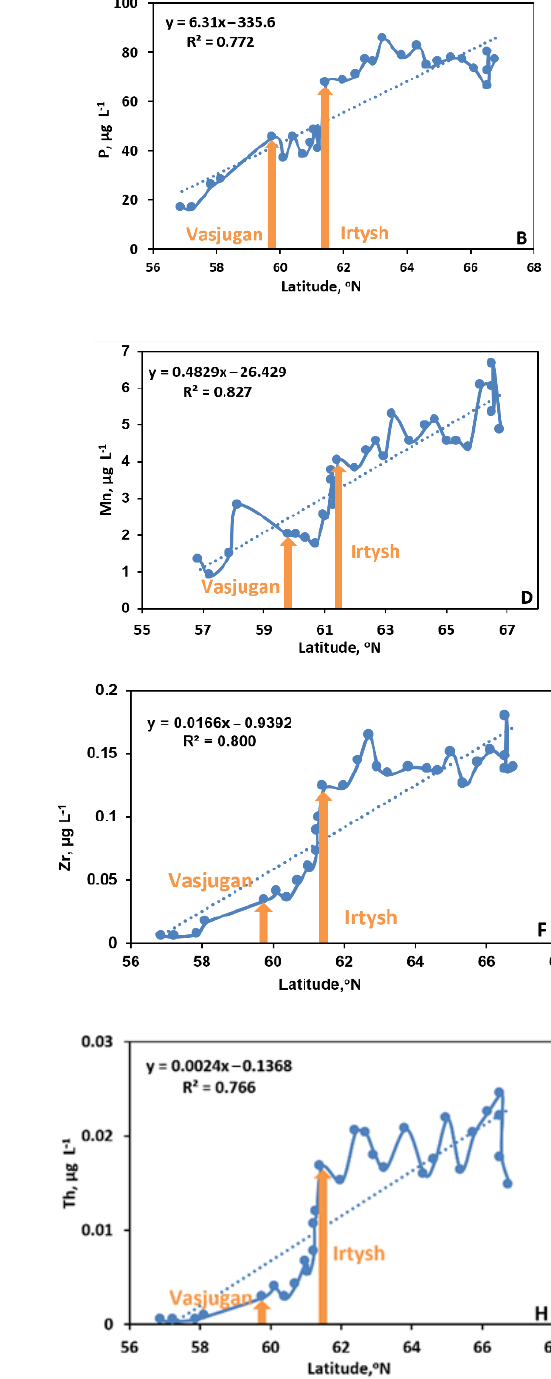
Figure 3. Latitudinal trends of DOC ( A ), nutrients (P ( B ), Fe ( C ), Mn ( D ) and Ni ( E )) and insoluble trace elements (Zr ( F ), La ( G ) and Th ( H )), showing a strong increase in concentration in the Ob main stem after the confluence with the Vasyugan and Irtysh River (shown by arrows).